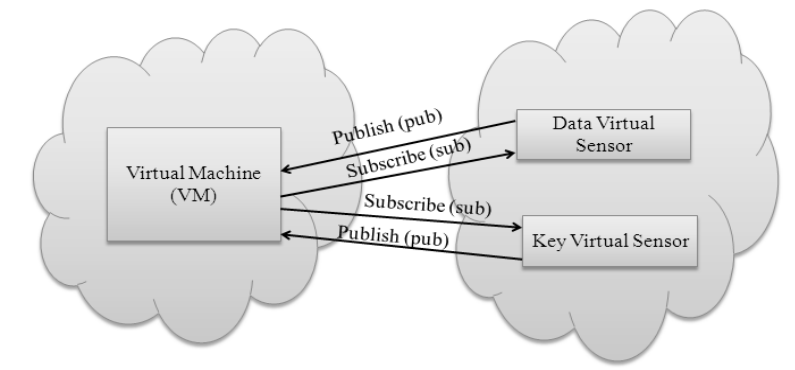
Figure 4. Interconnection between Virtual machine and Virtual Sensors (database) using pub/sub